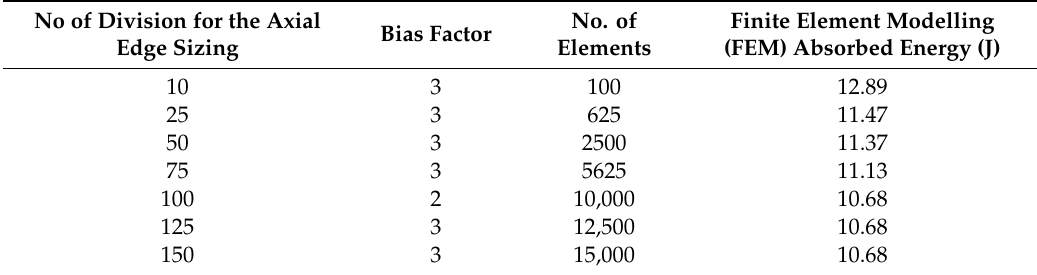
Table 8. Mesh convergence check for 20 J case.